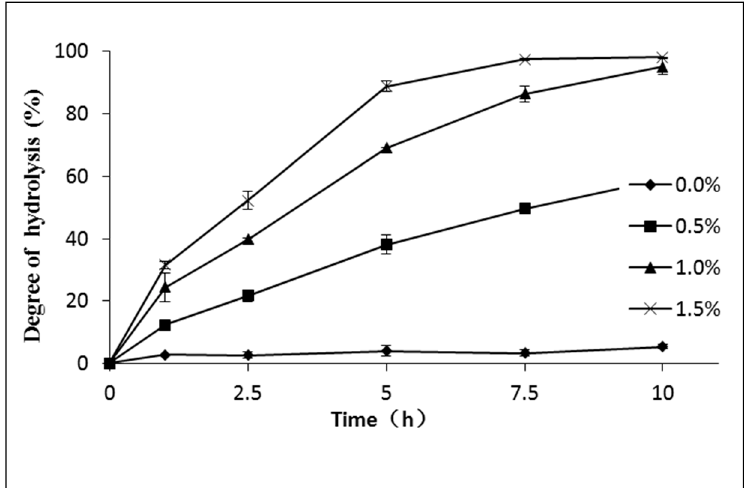
Figure 9. The e ff ect of sodium dodecylsulfate dosage (based on oil weight) to the hydrolysis of Figure 9. The effect of sodium dodecylsulfate dosage (based on oil weight) to the hydrolysis of Schizochytrium sp. oil. (Reaction temperature = 95 ◦ C, Water to oil ratio = 3:1 (w:w), 1.4 mol / L sulphuric Schizochytrium sp. oil. (Reaction temperature = 95 °C, Water to oil ratio = 3:1 (w:w), 1.4 mol/L sulphuric acid, 750 acid, 750 rpm).